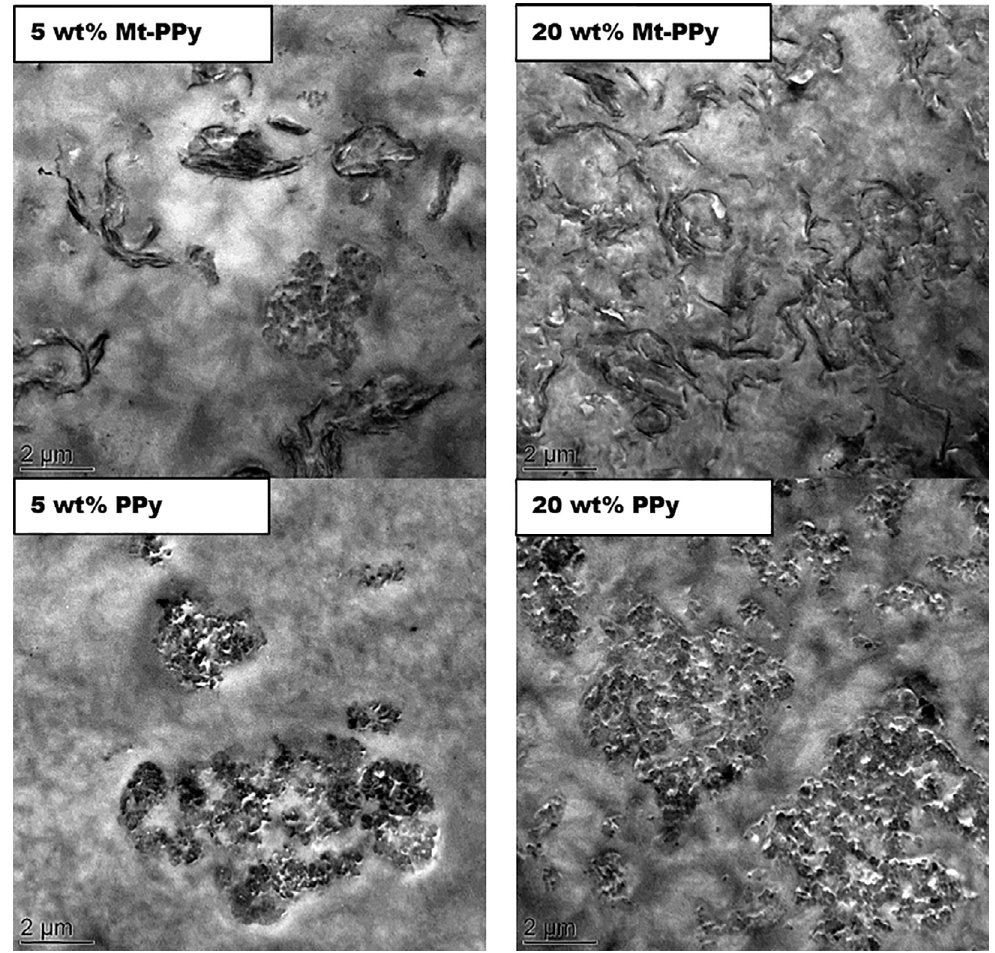
Figure 3. TEM micrographs of PBAT/Mt-PPy composites and PBAT/PPy blends filled with 5 wt% or 20 wt% of